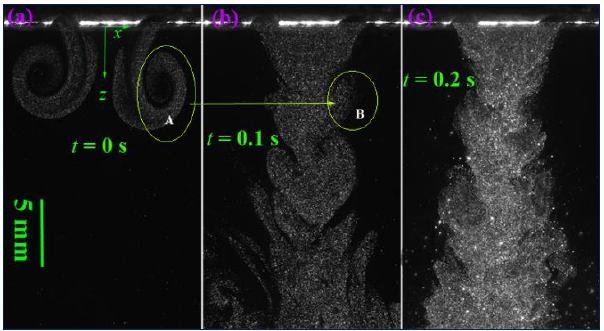
Figure 12. The evolution of air turbulence at continuous time instants of ( a ) t = 0 s, ( b ) t = 0.1 s, and ( c ) t = 0.2 s. The real size for each sub-image is 35.9 mm × 21.5 mm.